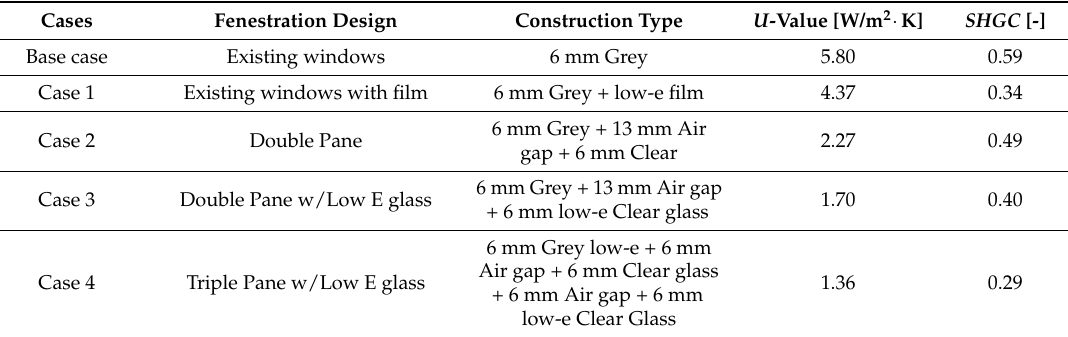
Table 7. Thermal-optical characteristics of fenestration retrofitting